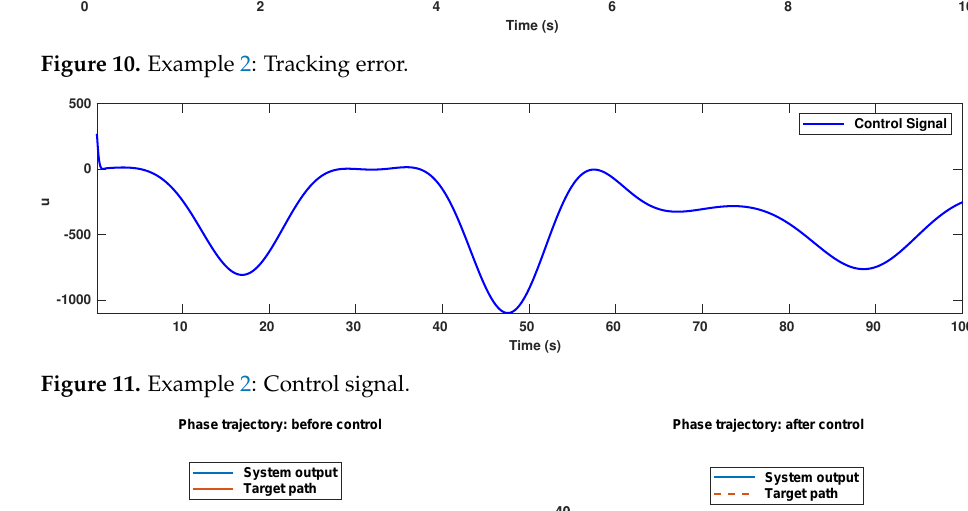
Figure 11. Example 2: Control signal.